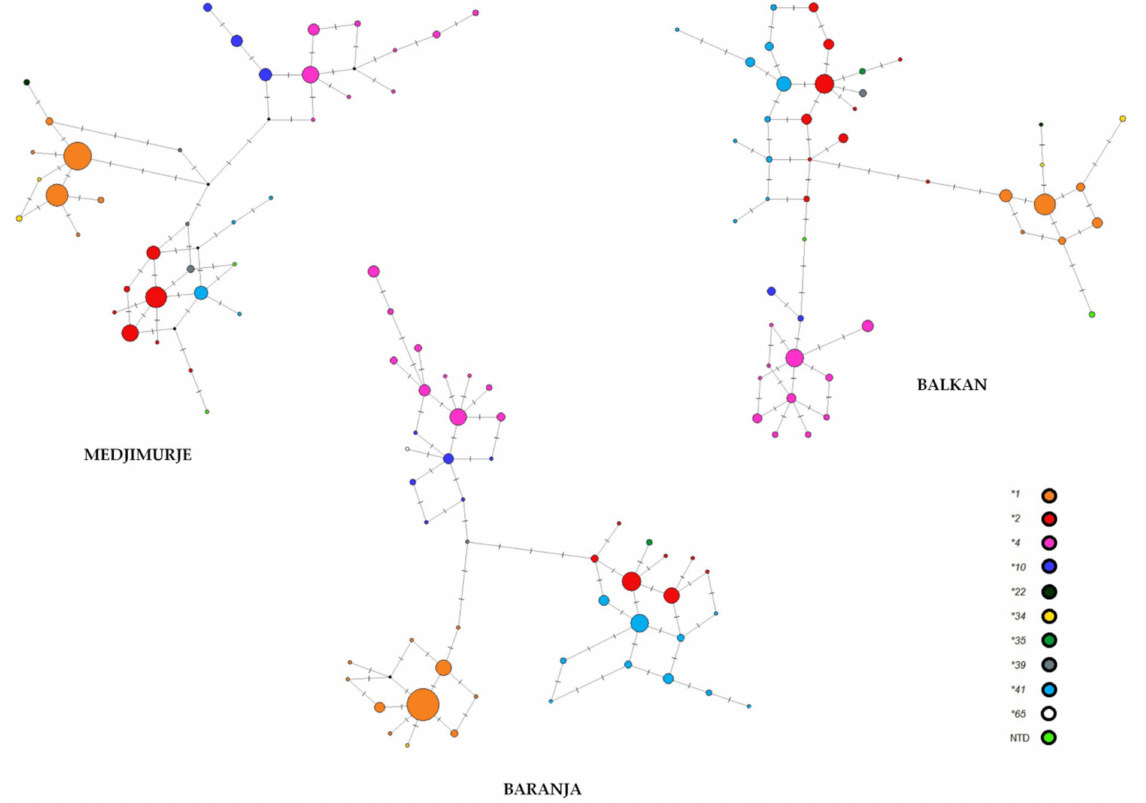
Figure 3. Median-joining networks of CYP2D6 haplotypes in Roma from Balkan, Baranja, and Med- jimurje. Haplotypes belonging to the same star allele are shown in a separate color. Distance between nodes is proportional to the numbers of SNPs whose alleles differ. SNPs are represented with lines. Size of nodes is an approximation of haplotype frequency. Black nodes represent phylogenetically possible haplotypes not found in this study. (NDT—not